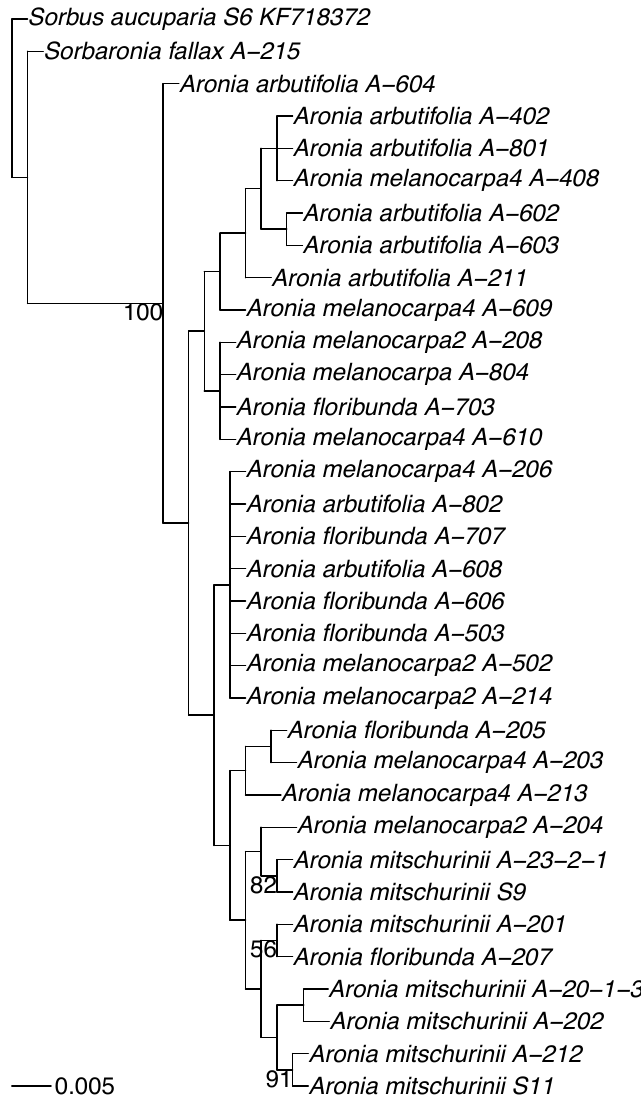
Fig. 1. ML tree resulted from the analysis of concatenated ITS2 and rbc L